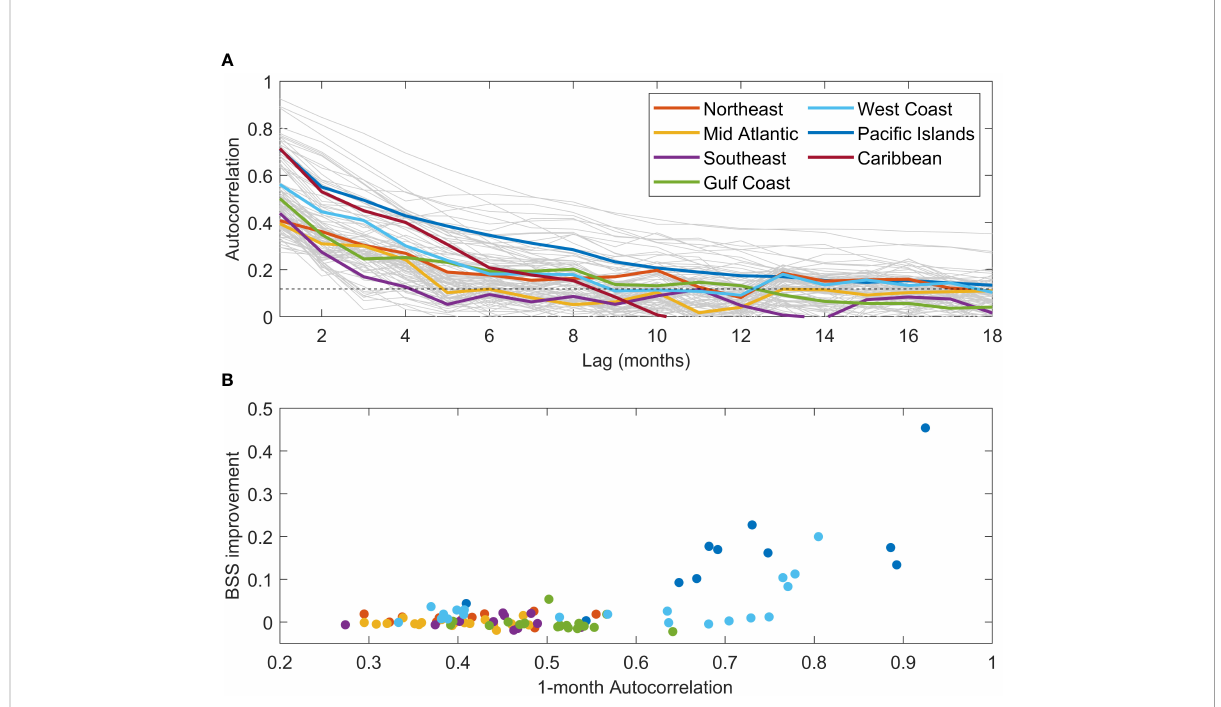
FIGURE 7 Autocorrelation of monthly MSL anomaly (A) for the 1997 – 2019 period for each of the 98 tide gauges (gray lines). The mean autocorrelation for each region (thick colored lines) and the positive 95% con fi dence limit of a white-noise autocorrelation (horizontal dashed line) are shown. Panel (B) shows the improvement in the BSS when using the 1-month damped persistence prediction compared to the climatological prediction (y-axis) as a function of the 1-month autocorrelation of monthly MSL anomaly (x-axis). Colors represent the same regions as in panel (A)